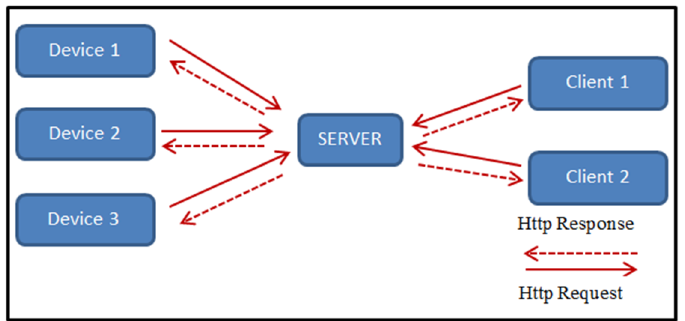
Figure 5. HTTP flow diagram .